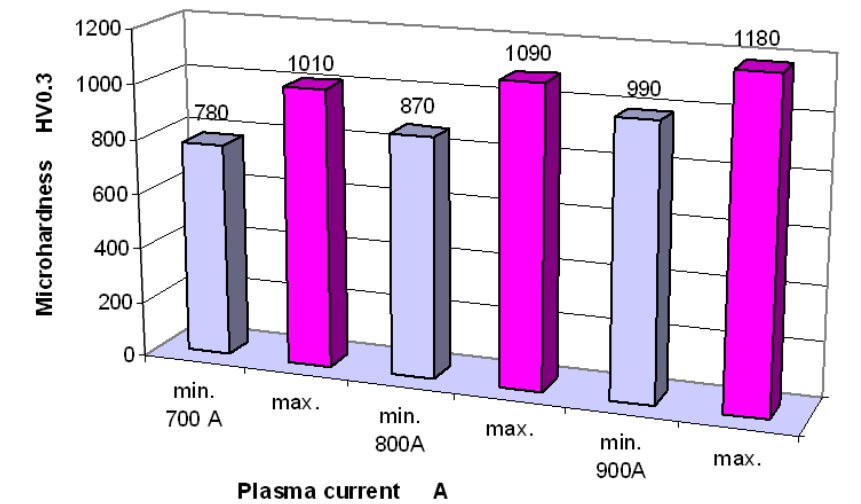
Figure 2 – Results of th e microhardness of Al 2 O 3 coatings Рис . 2 – Результаты микротвердости покрытия Al 2 O 3 Слика 2 – Резултати микротврдоће превлака Al 2 O